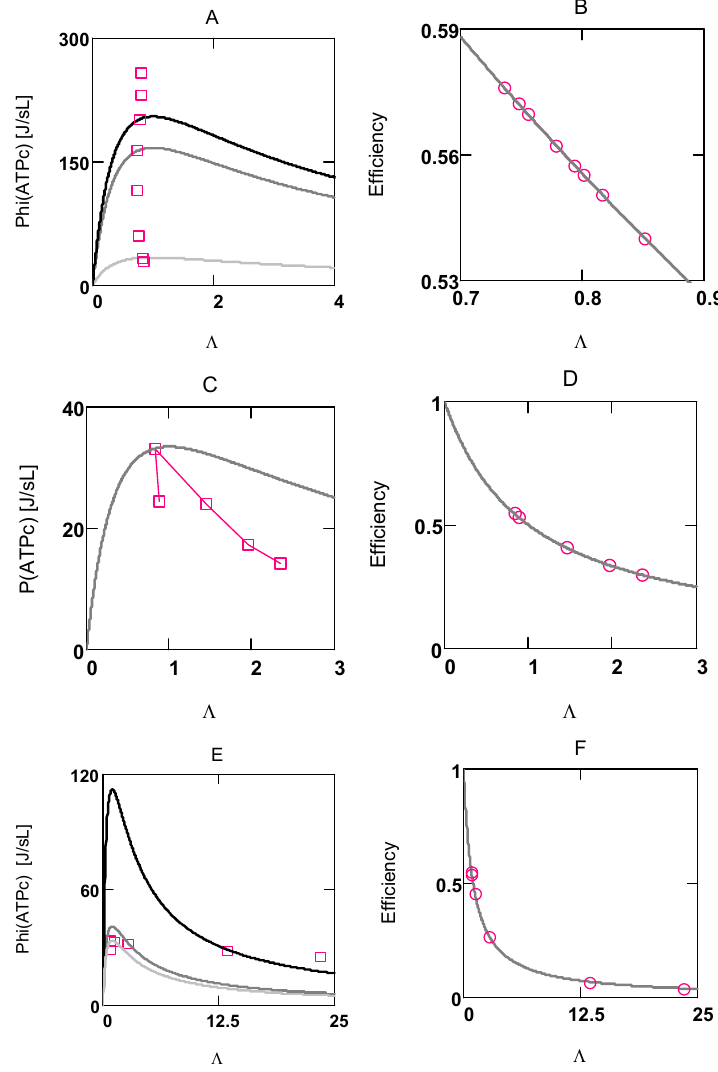
Figure 9. Power output and efficiency, respectively, versus conductance ratio